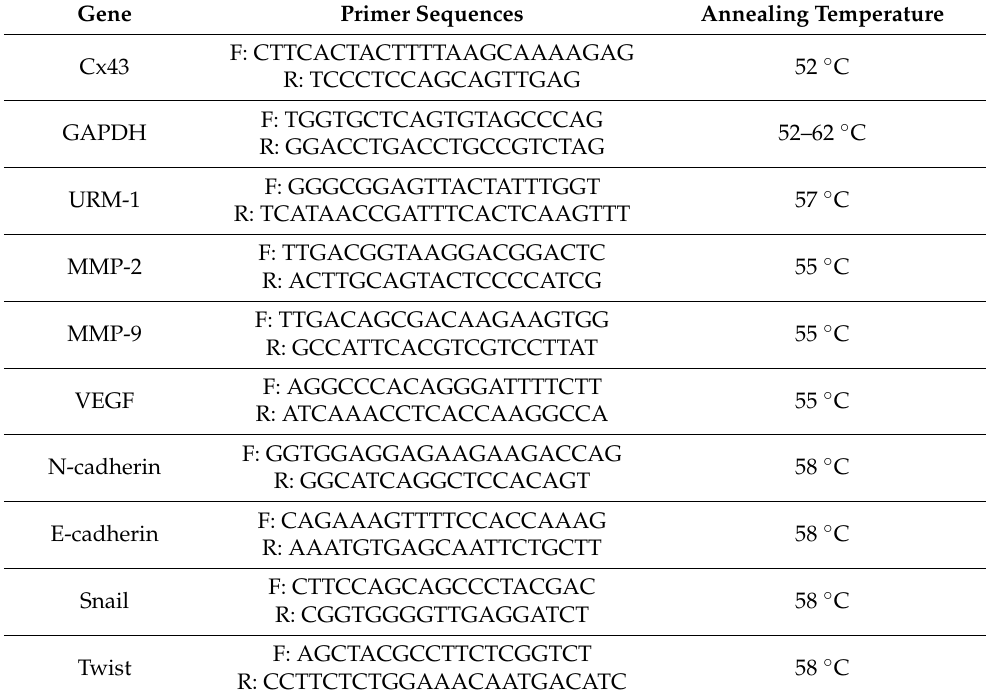
Table 1. qPCR primer